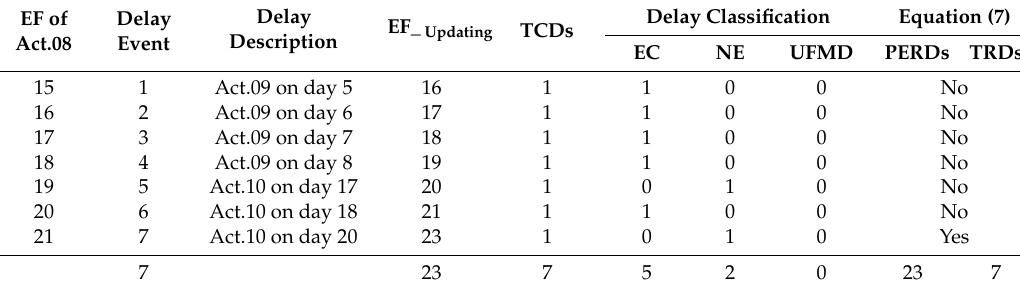
Table 3. The analysis results for period (22).